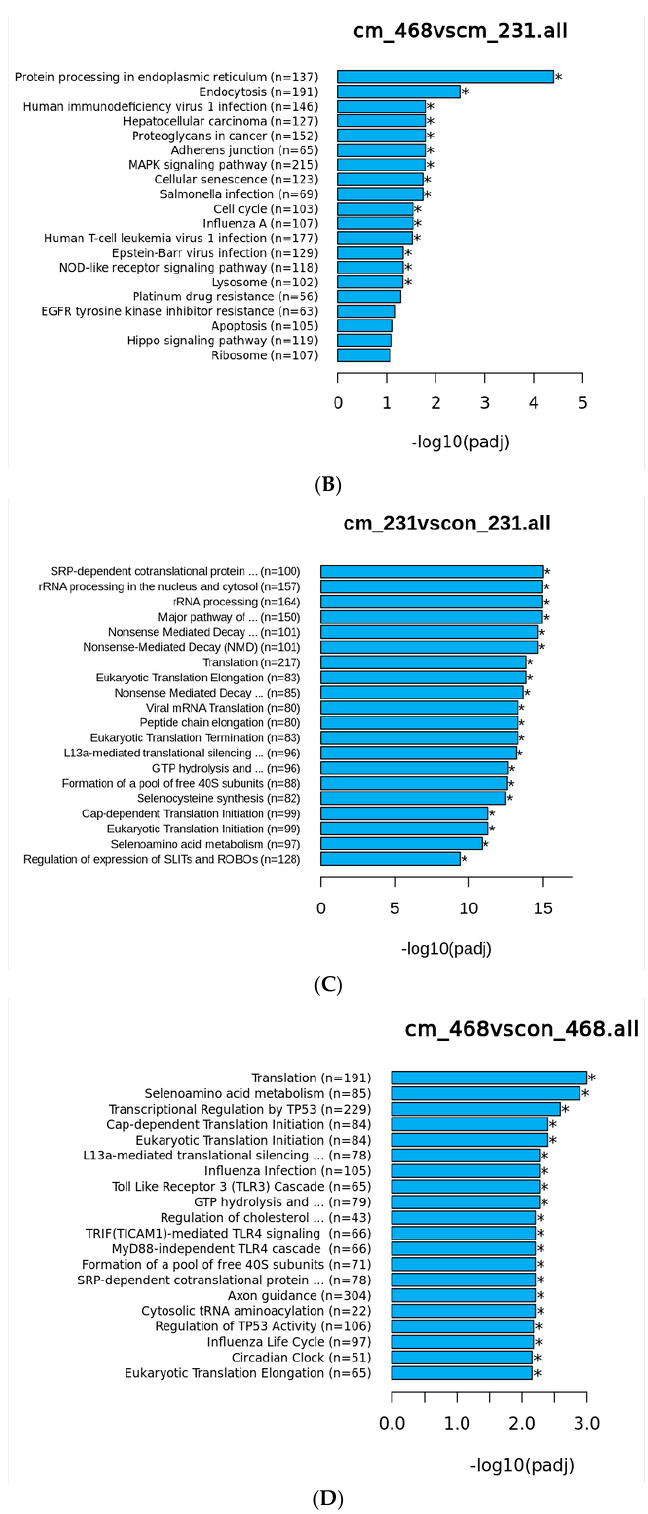
Figure 2. Gene ranking distribution from RNA sequencing data and REACTOME gene set enrichment data of MDA MB 231 vs. MDA MB 468 adipocyte-conditioned media samples. ( A ) Butterfly plot of gene ranking distribution for MDA MB 231 CM vs. MDA MB 468 samples. ( B ) Bar graph of gene sets significantly enriched in MDA MB 468 CM compared to MDA MB 231 CM samples. ( C ) Bar graph of gene sets significantly enriched in MDA MD 231 CM vs. control samples. ( D ) Bar graph of gene sets significantly enriched in MDA MD 468 CM vs. control samples. * significantly upregulated ( p <